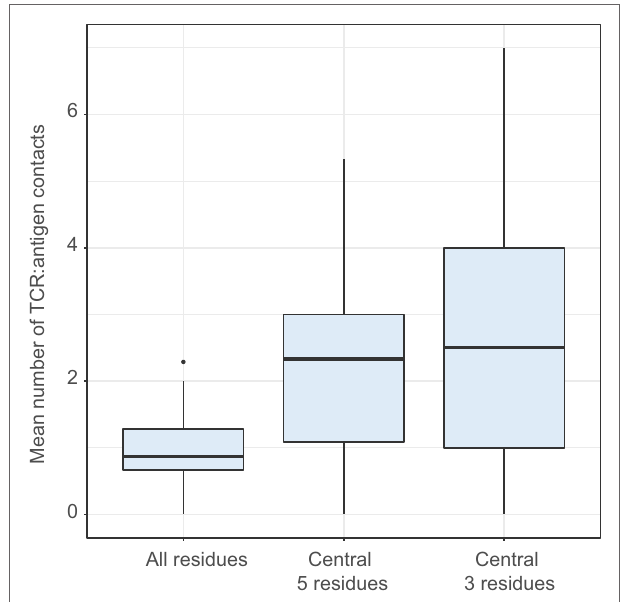
FigUre 8 | Number of CDR3:antigenic peptide contacts in structural data. Comparing the mean number of contacts for entire CDR3 (All positions) and its central region (central 5 residues and central 3 residues). ANOVA followed by a post hoc Tukey test shows significantly higher number of contacts for the central region: P < 10 − 8 when comparing 5 and 3 central residues to all residues, but no difference between 5 and 3 central residues ( P = 0.42). The analysis was performed for T-cell receptor (TCR) beta chain using 110 human TCR:pMHC complexes from Protein Data